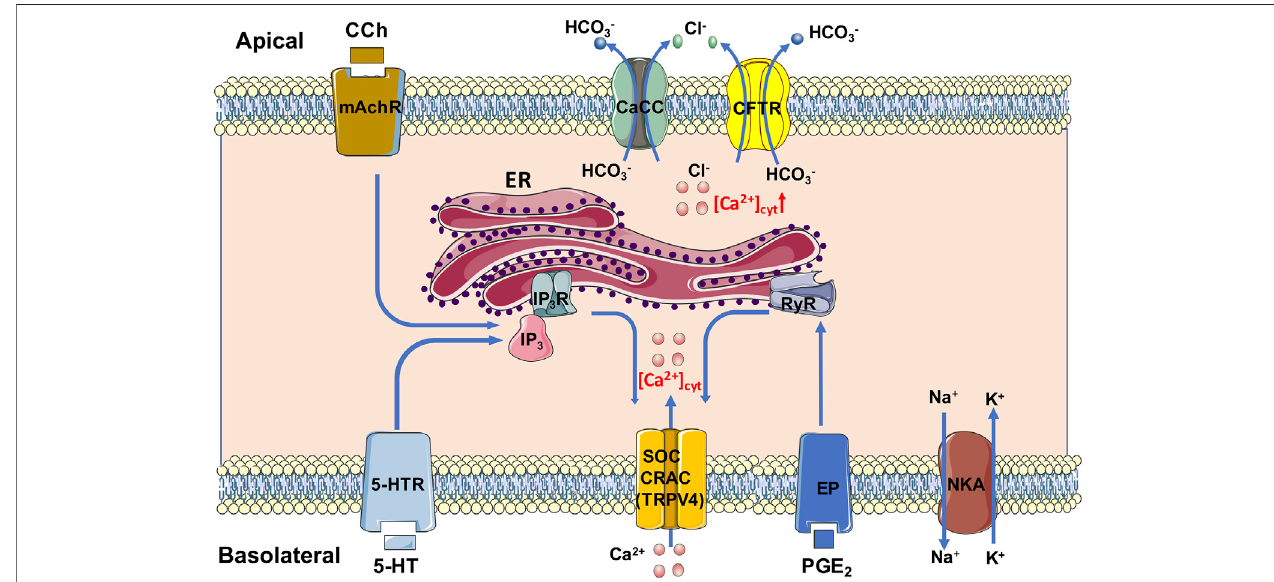
FIGURE 13 | Mechanism diagram of secretagogues mediating Ca 2+ signaling in duodenal epithelial cells via TRPV4-constituted serosal SOCE mechanism. PGE 2 and 5-HT stimulate this mechanism exclusively from serosal side of the duodenum; CCh stimulates it from both sides. 5-HT and CCh trigger the ER Ca 2+ release to initiatetheSOCElikelyviaIP 3 /IP 3 R,butPGE 2 triggersitlikelyviaRyR.CaCC, Ca 2+ -activatedCl − channels;CFTR,cystic fi brosistransmembraneconductanceregulator; CRAC, Ca 2+ release-activated Ca 2+ channel; ER, endoplasmic reticulum; EP, PGE 2 receptor; IP 3 and IP 3 R, inositol 1,4,5-triphosphate and its receptor; mAchR, muscarinicacetylcholinereceptor;NKA,Na + /K + ATPase;RyR,ryanodinereceptor;SOC,store-operatedchannels;TRPV4,transientreceptorpotentialV4;5-HTR,5-HT